Question: Summarize what this figure shows in one sentence.
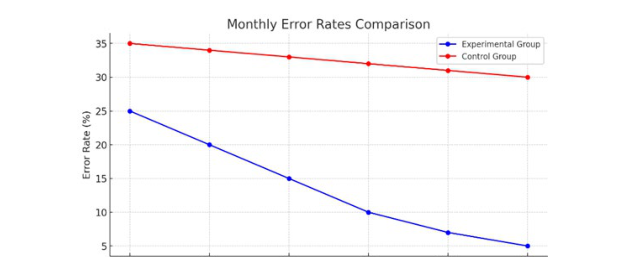
Answer: Comparison of Code Error Rates